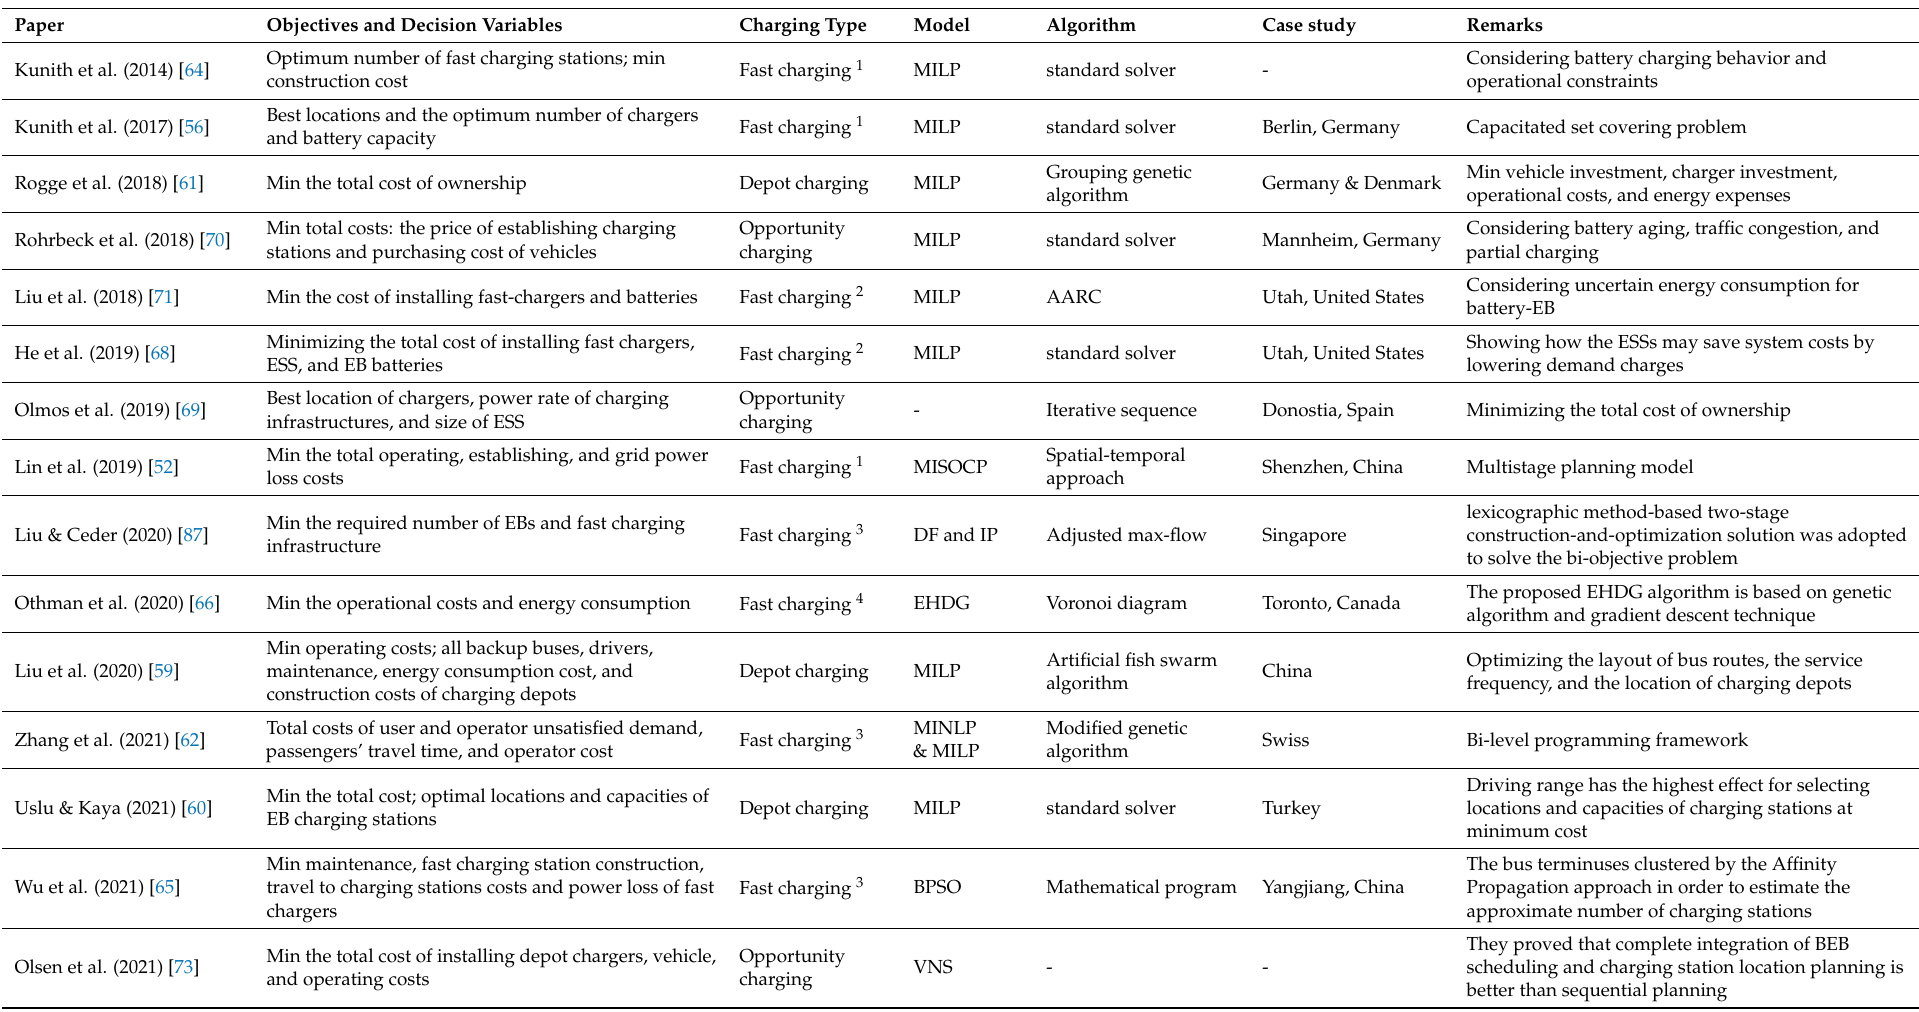
Table 5. Comparison of different studies on EBs’ charging infrastructure location